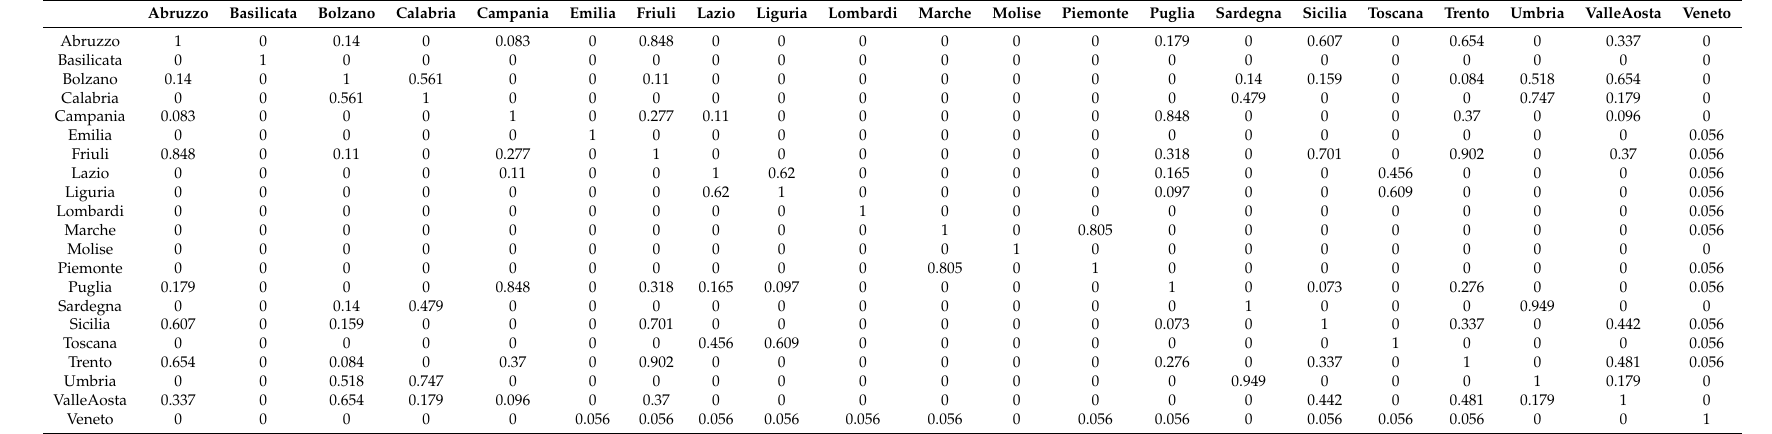
Table A4. Similarity values of Hospitalized with Symptoms network in the third